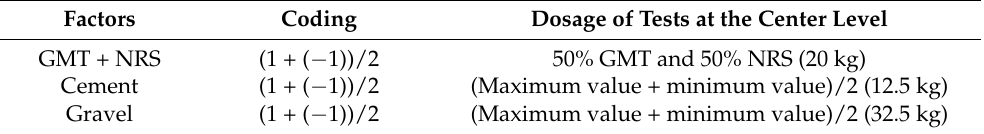
Table 2. Tests at the center level.